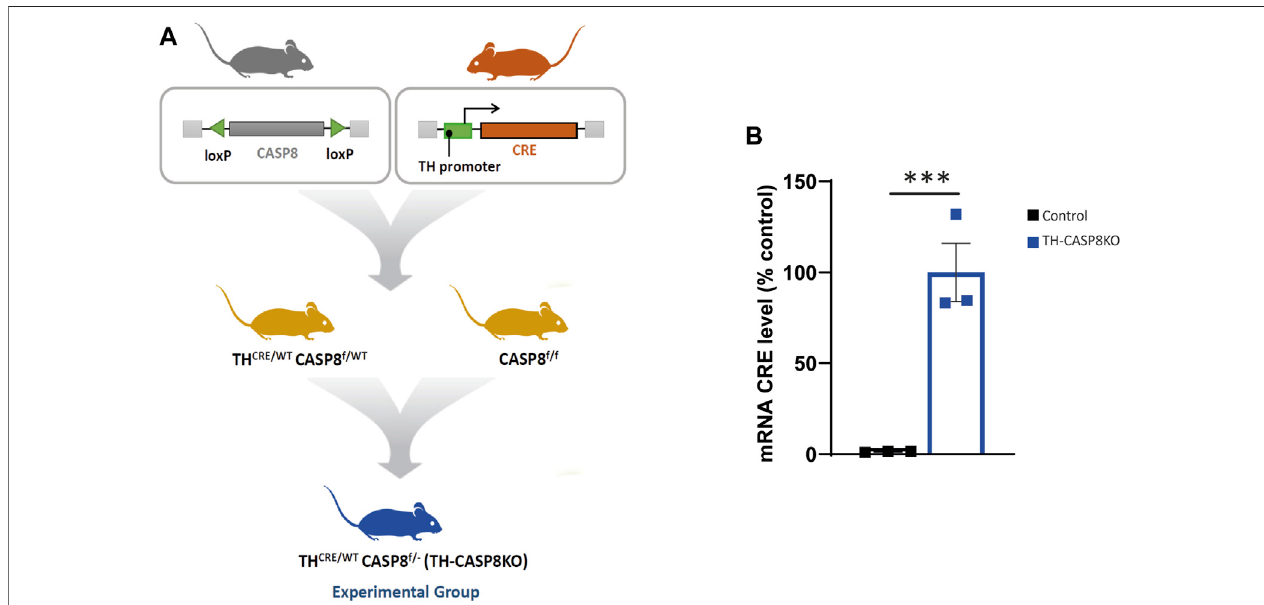
FIGURE1| GenerationofconditionalTH-CASP8KOmice. (A) CrossingstrategyforthegenerationofTH-CASP8KOmice(experimentalgroup). (B) qPCRanalysis of the mRNA expression of CRE. Data are expressed as mean ± SEM of n = 3 mice/group. The two-tailed unpaired t test was used. ***, p < 0.01 versus control mice.